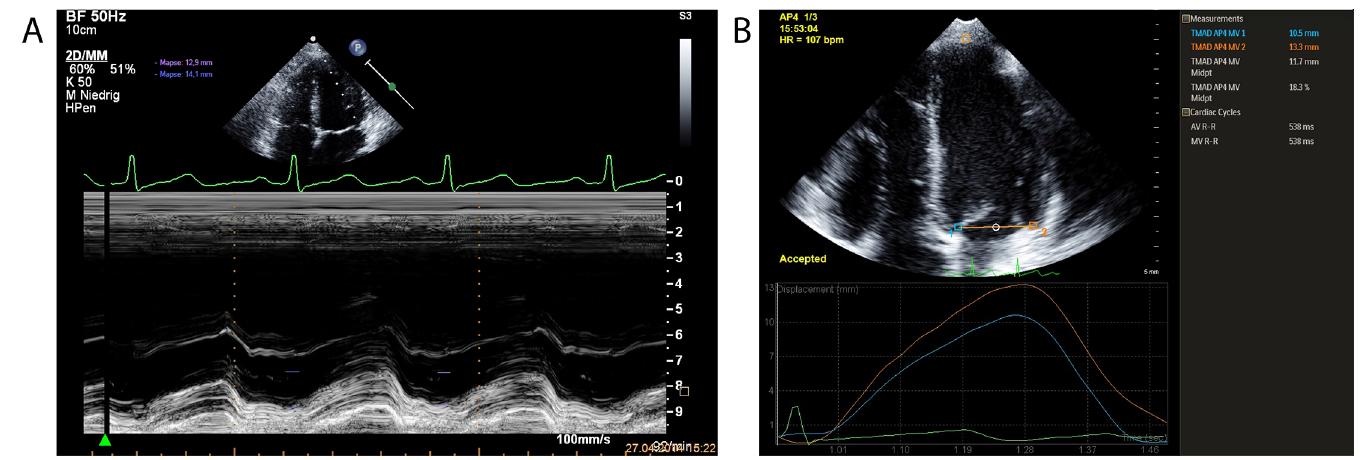
Fig 1. Echocardiographic image samples of MAPSE imaging. A. M-mode derived MAPSE measurement, B. B-mode derived MAPSE measurement.